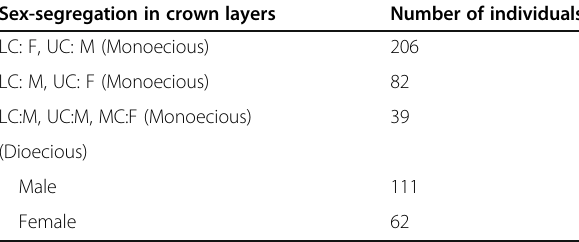
Table 1 Sexual-segregation among crown layers within the populations of Cedrus deodara ( n =500), LC: lover crown layer, MC: middle crown layer, UC: upper crown layer, M: male, and